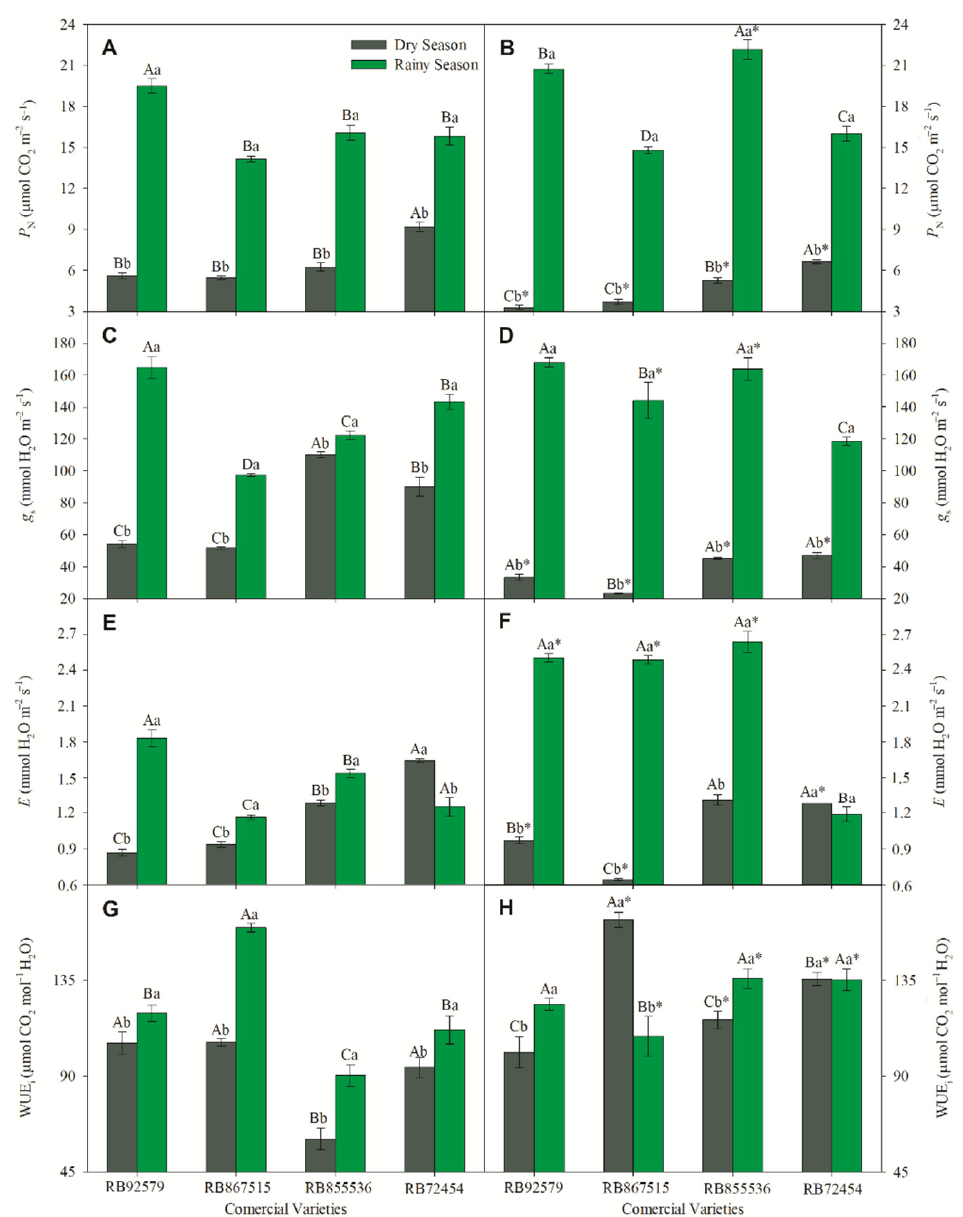
Figure 2. Net photosynthesis ( P N ; ( A , B )), stomatal conductance ( g s ; ( C , D )), transpiration ( E ; ( E , F )), and intrinsic water use efficiency (WUE i ; ( G , H )) measured in four varieties (RB92579, RB867515, RB855536, and RB72454) of sugarcane. The evaluations were made in dry season (gray bars) and rainy season (green bars) at 8:00 to 10:00 h ( A , C , E , G ) or at 12:00 to 13:00 h ( B , D , F , G ). Different lowercase letters denote significance within season for each variety, and different capital letters denote significance within varieties for the same season. An asterisk (*) denotes significance within 8:00 to 10:00 h and 12:00 to 13:00 h measurements in the same treatment.